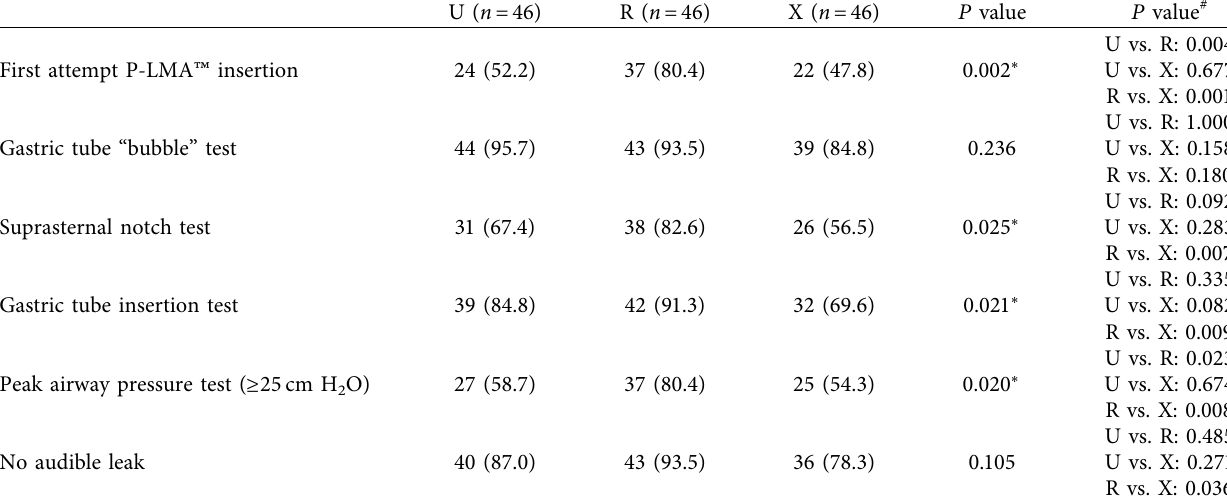
Table 3: Comparing diferent operating table height positions in determining successful frst attempt P-LMA TM insertion and its related individual positional and performance test.